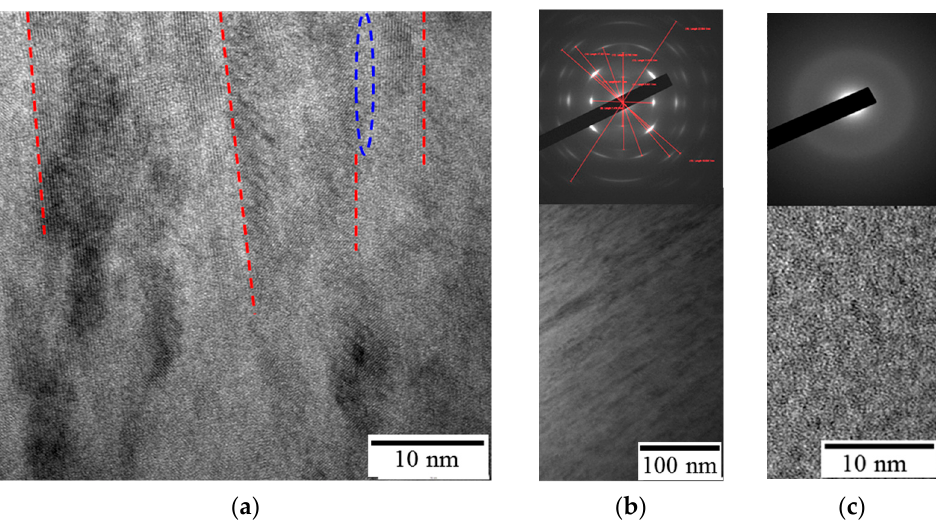
Figure 5. Cross-section TEM images and SAED patterns for Coatings 1A ( a , b ) and 2N ( c ). The red dashed lines correspond to the boundaries between columnar grains, and the blue oval shows amorphous